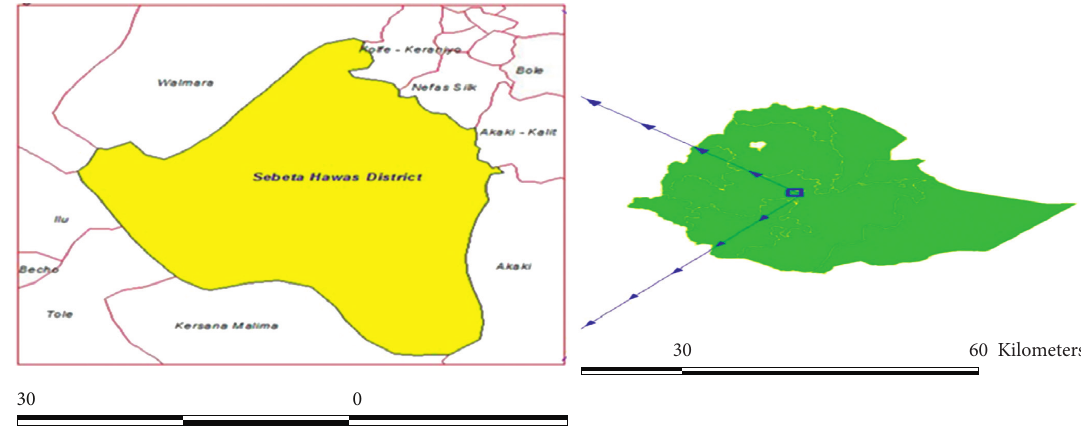
Figure 1: Map of the study